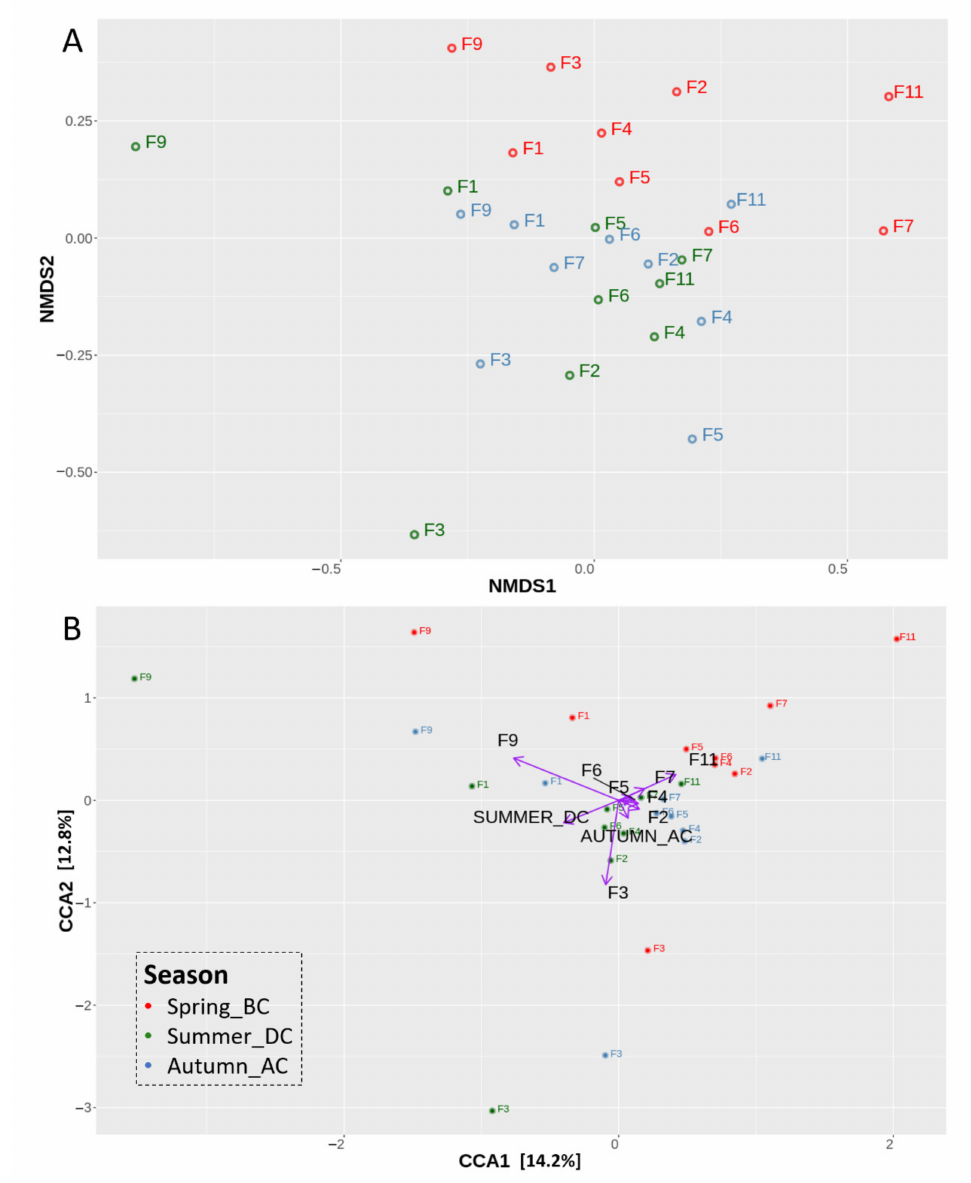
Figure 3. Nonmetric multidimensional scaling (NMDS) plot representing bacterial communities’ structures similarity ( A ) and Canonical correspondence analysis (CCA) of the relative variance of OTUs in the soil samples representing the effect of runner bean cultivation period on the bacterial community abundance ( B ) for nine sites (F1–F11) over three different seasons: Spring_ before cultivation (BC), Summer_during cultivation (DC), Autumn_after cultivation (AC), based on the presence/absence of runner bean crop. The weights of the most explanatory variables are represented with black font colour and purple